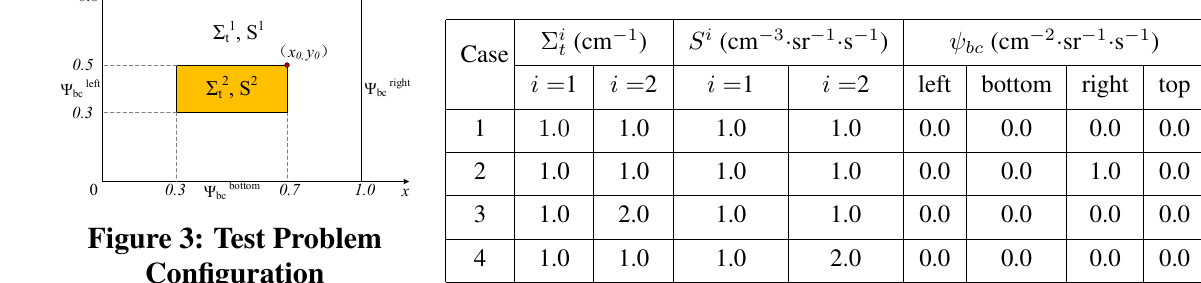
Figure 3: Test Problem